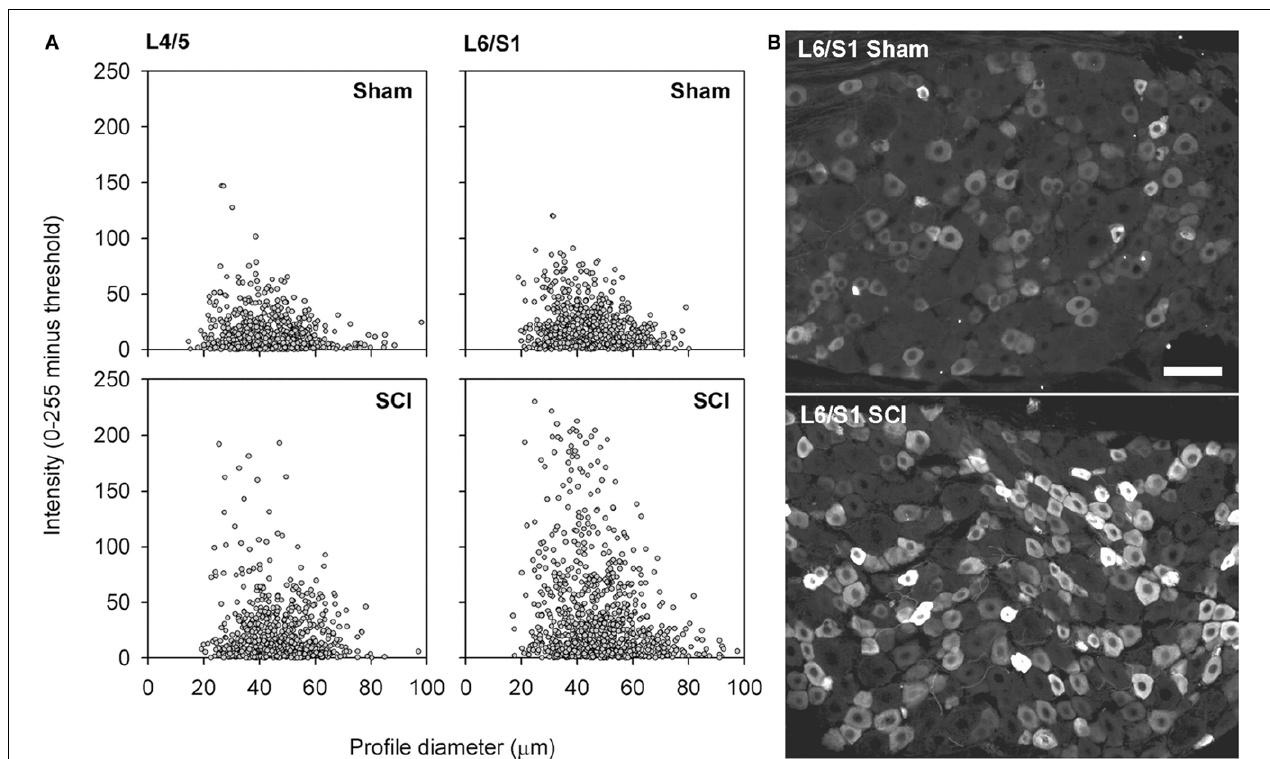
increase in signal intensity at 3months afterT3 SCI for both L4/L5 DRGs and L6/S1 DRGs (K–S goodness-of-fit tests on cumulative intensity-frequency distributions). (B) Representative images ofTRPV1-expression in the L6/S1 DRG, from a sham-injured control (top) and an animal withT3 SCI (bottom). Scale bar = 50 µ